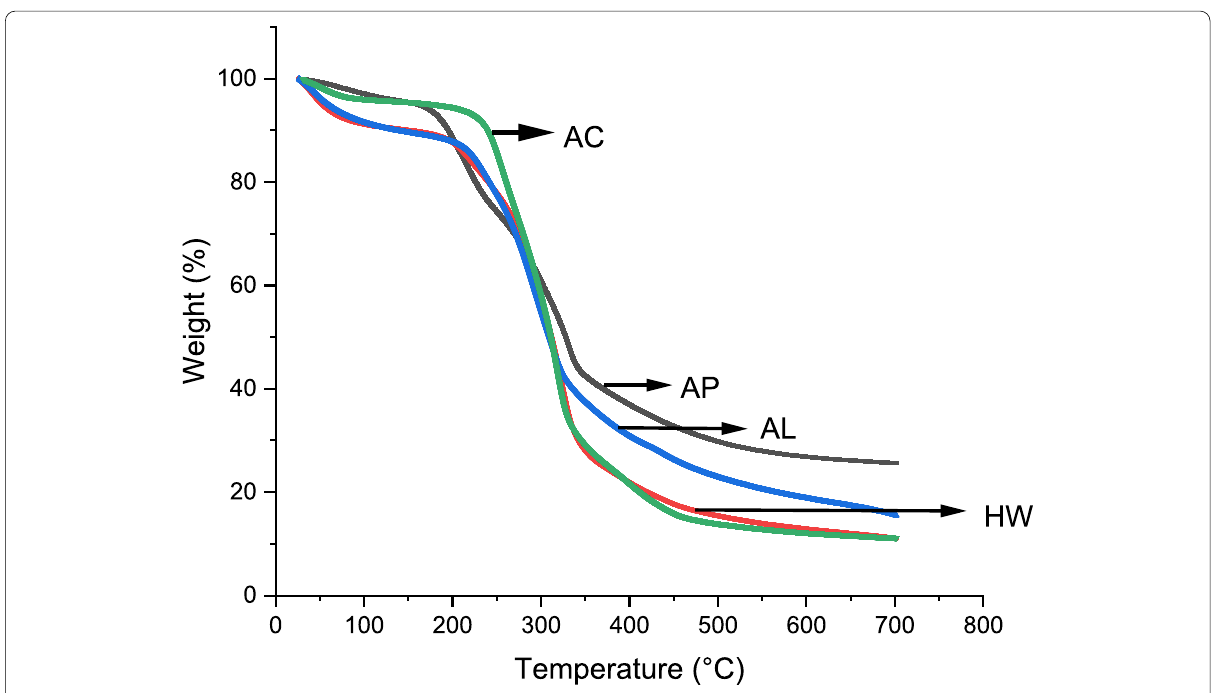
Fig. 3 Thermo gravimeteric curves of apple pomace and extracted dietary fibre